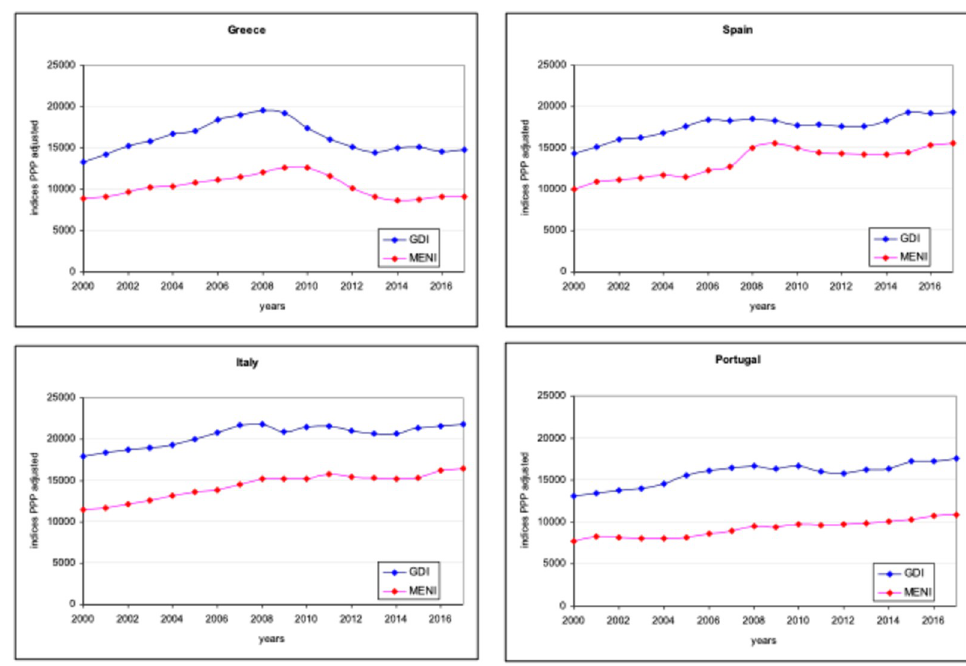
Fig 4. Time trends of Gross Disposable Income per capita PPP adjusted (GDI) and Equivalised Median Net Income PPP adjusted (MENI) by country: 2000–2017.